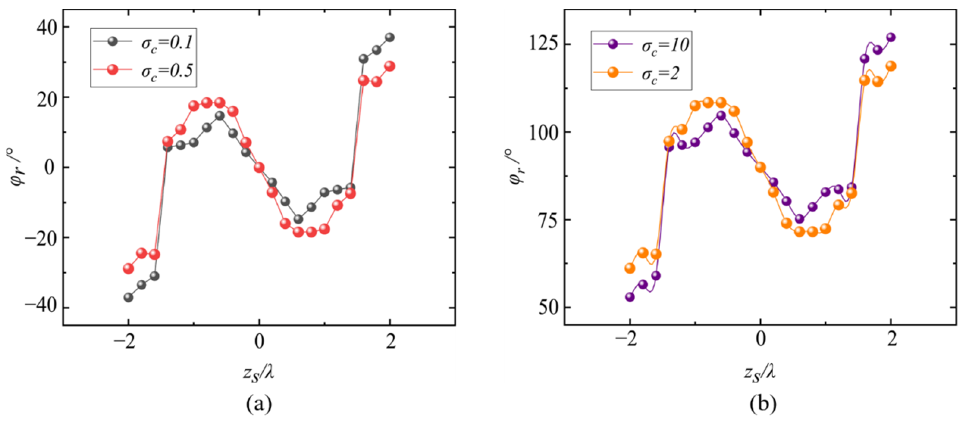
Figure 8. Variation in the rotational angle ϕ r for the transverse energy flow p with the beam propagation. Here, ( a ) σ c = 0.1, 0.5; ( b ) σ c = 2, 10. In both plots l = 1.